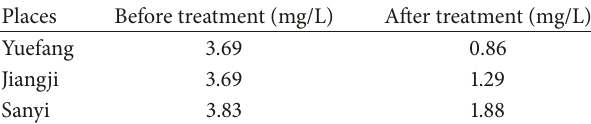
Table 2: Treatment of real water samples by Ce-bpdc. Places Before treatment (mg/L)